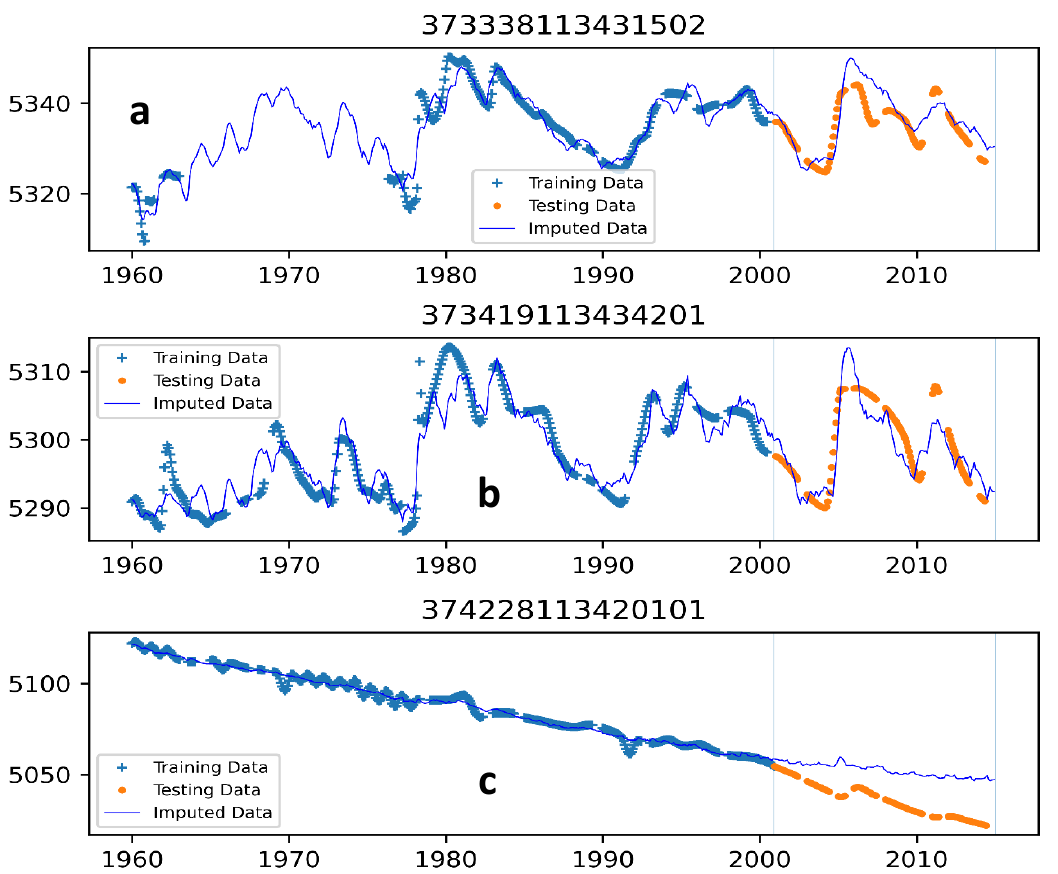
Figure 8. ELM results over a 15 year testing period from 2000–2015 for Wells 373338113431502, 373419113434201, and 373527113415101, as subfigures ( a – c ), respectively. Imputed data are solid blue lines, measured data used for training are blue crosses, and measured data used for testing are orange dots.